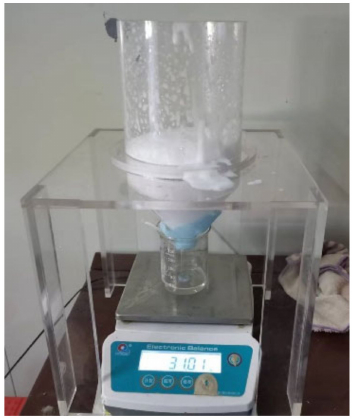
Figure 12. Foam stability test device.